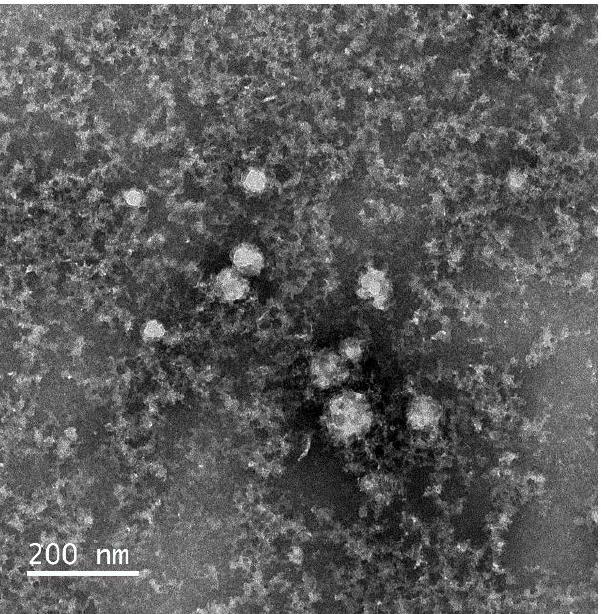
Figure 3. Electron microscopic analysis of purified USUV E protein. Purified USUV E antigen was negatively-stained with PTA and examined under EM. The scale bar indicates a size of 200 nm.